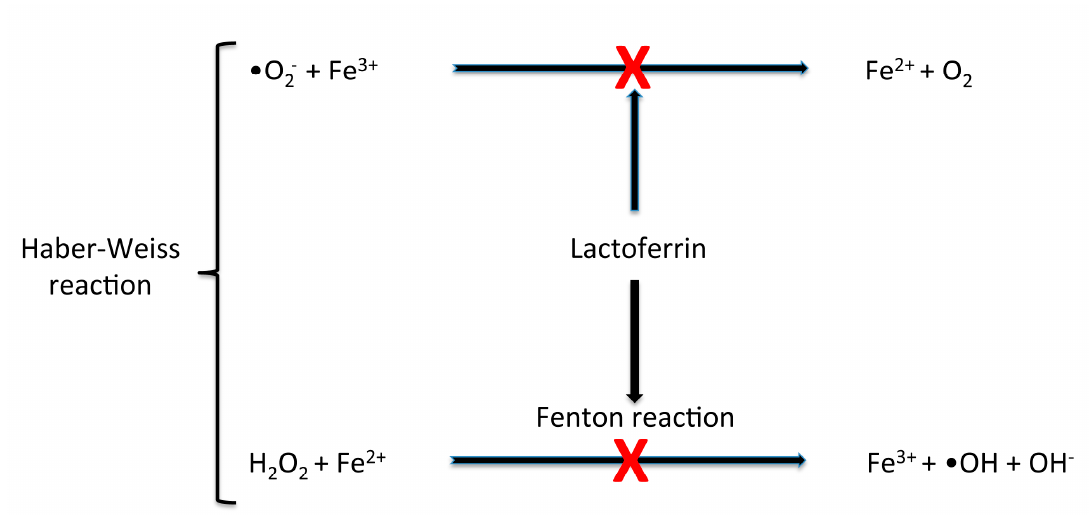
Figure 2. Lactoferrin protects against cellular damage induced by oxidative stress. It inhibits free ferric ion reactivity with superoxide molecules, thus limiting the formation of ferrous salt and ground state oxygen. This effect prevents the Fenton reaction in which the ferrous ion is oxidized by hydrogen peroxide to ferric ion, forming a hydroxyl radical and a hydroxide ion.